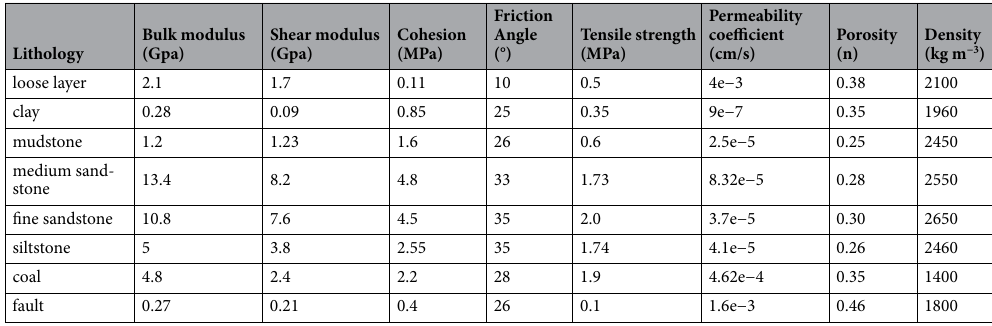
Table 1. Physical and mechanical parameters of the rock sequence at the 331 working